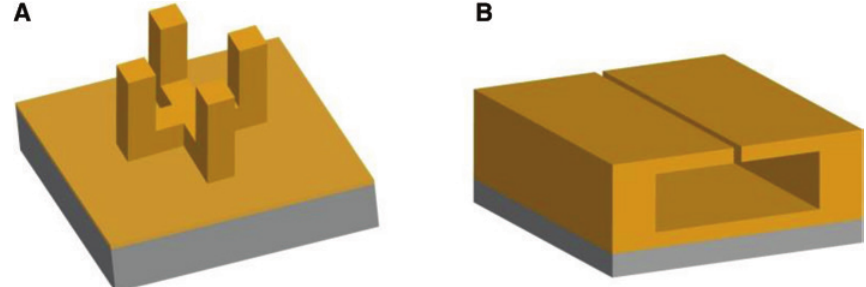
Figure 21: Two all-metal perfect absorber designs.